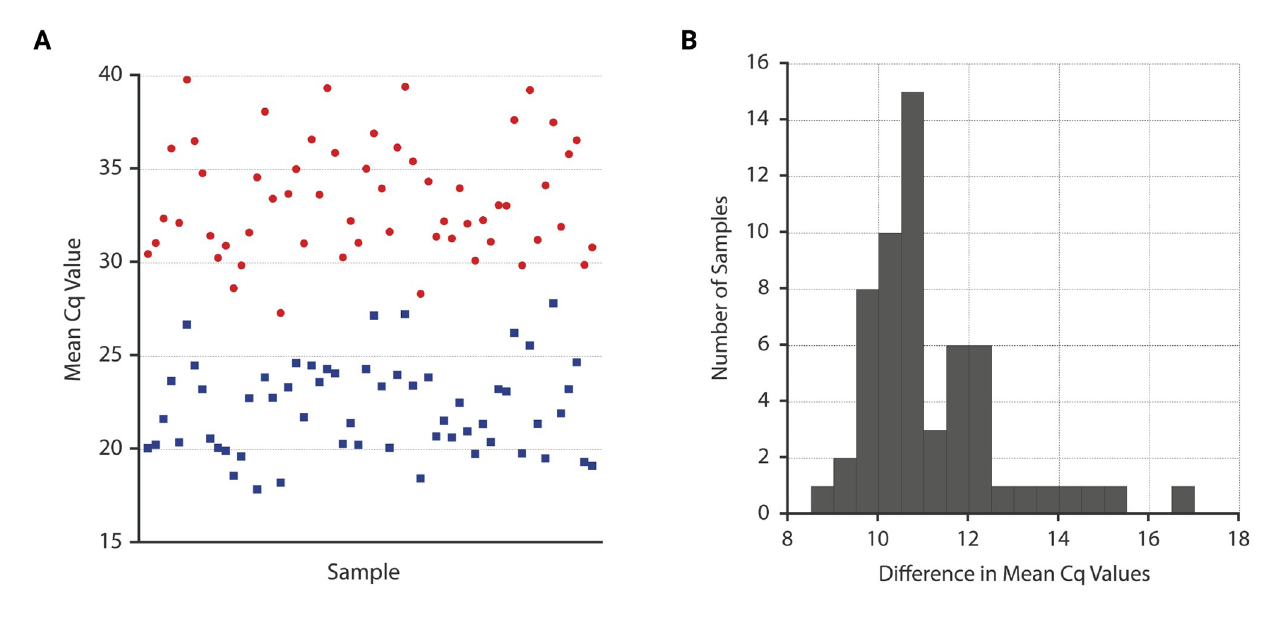
Fig 2. Differences between mean Cq values for samples producing positive results for both reference and index assays. (A) For each co-positive sample, mean Cq values were plotted for both the ribosomal ITS-targeting reference assay (red circles) and the repetitive sequence-targeting ( Mp R1) index assay (blue squares). (B) For all co-positive samples, a difference was calculated by subtracting the mean Cq value for the results of index assay testing from the mean Cq value resulting from reference assay testing. Differences were then binned and plotted. The average difference resulting from all plotted (co-positive) samples was 11.16 cycles.